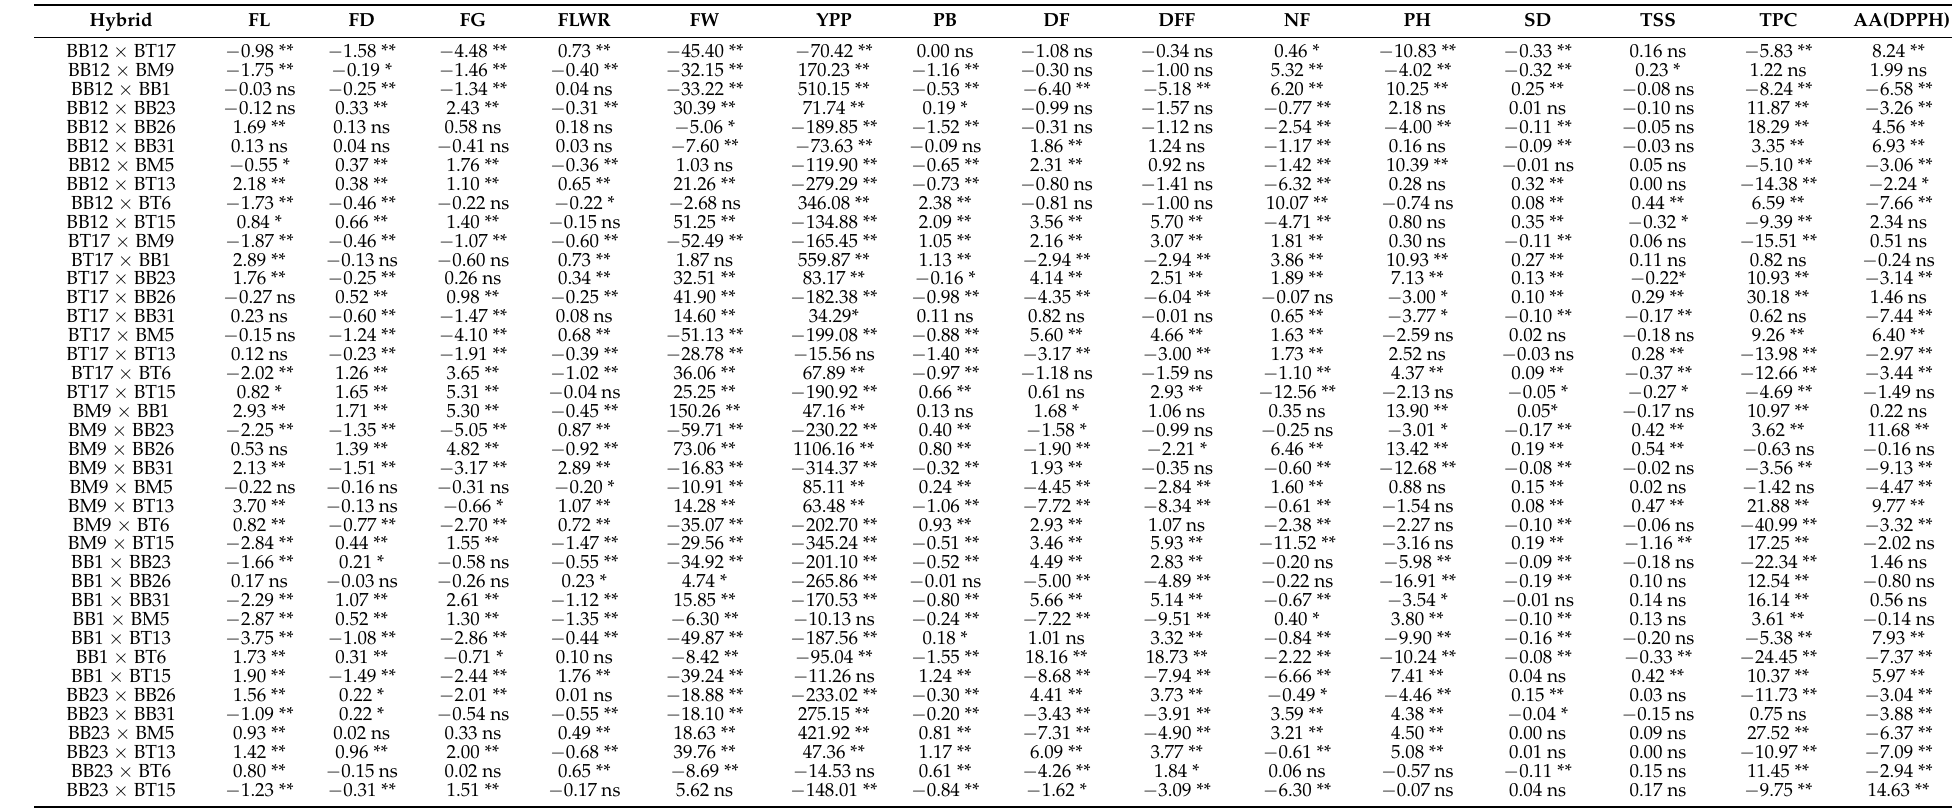
Table 7. Estimation of specific combining ability (SCA) effects on hybrids for 15 traits of